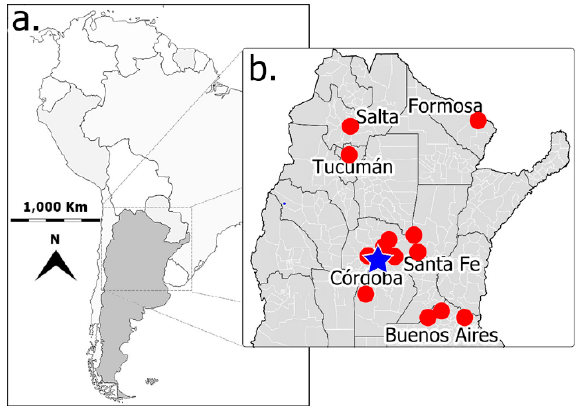
Figure 1. Source location of the Fusarium spp. isolates used for the mycovirus survey. ( a ) South America political map in which the Argentine national territory is painted in dark gray, and black lines indicate international divisions. ( b ) Zoom-in view of the central and northern regions of Argentina; red dots represent the areas where maize and sorghum grains were taken to sample for Fusarium spp. isolates. The blue star indicates the site where the Fusarium isolates infected with mycovirus were obtained ( F. verticillioides isolate FvSec505 from maize and F. andiyazi isolate Fa162 from sorghum). Black lines indicate provincial limits, and white lines, departmental regions within provinces in Argentina (grey), whose names are